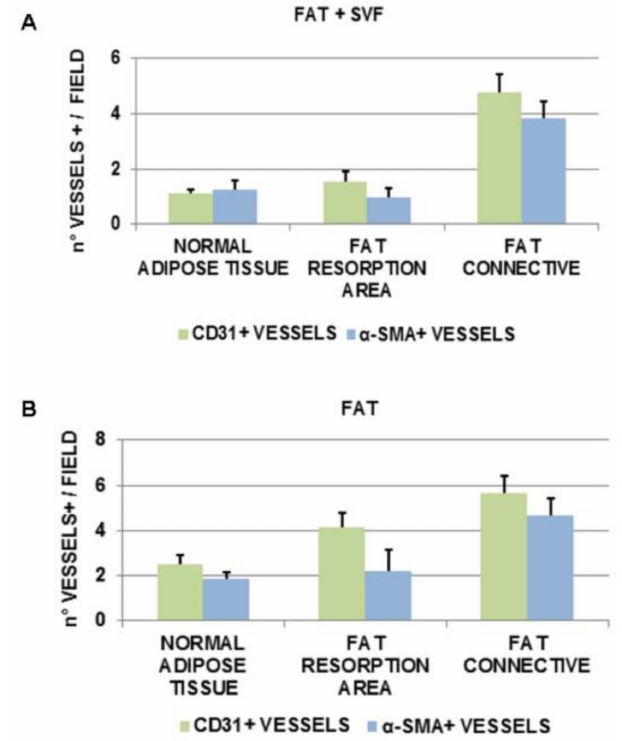
Figure 7. Angiogenesis data. ( A ) FAT + SVFs group showed similar amount of CD31+ and α -SMA+ vessels ( p > 0.05), demonstrating the prevalent presence of mature vessels into the considered areas. This phenomenon was not totally reproducible in FAT group ( B ) that has higher, but non-significant, numbers of CD31+ vessels in comparison with to α -SMA+